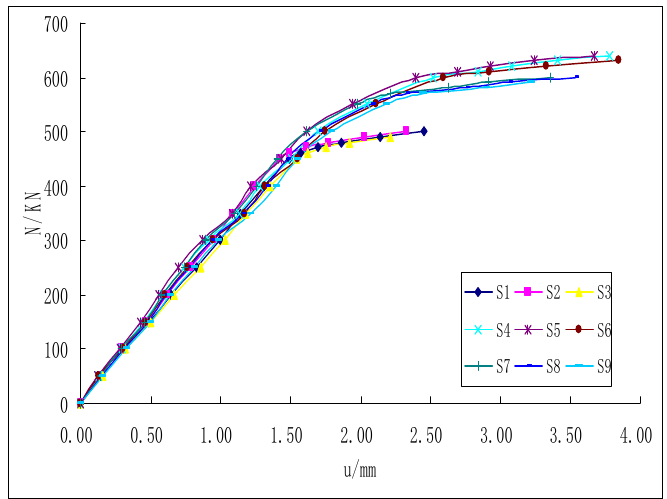
Figure 9. The load and the vertical displacement.